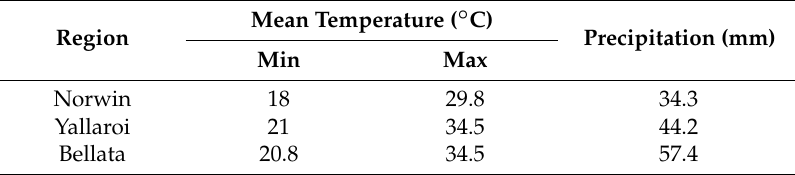
Table 7. Sorghum growing regions mean precipitation and temperature during grain filling.